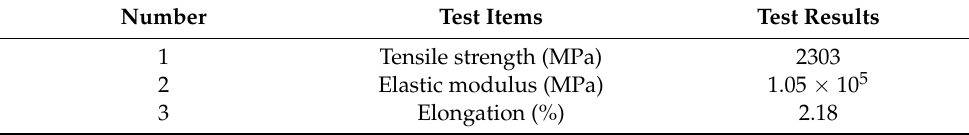
Table 3. Technical indexes of basalt fiber sheet.